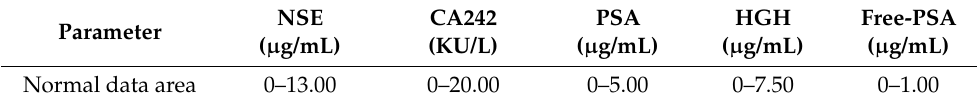
Table 3. Five lowly relevant NSCLC diagnostic and decision parameters and their normal ranges.